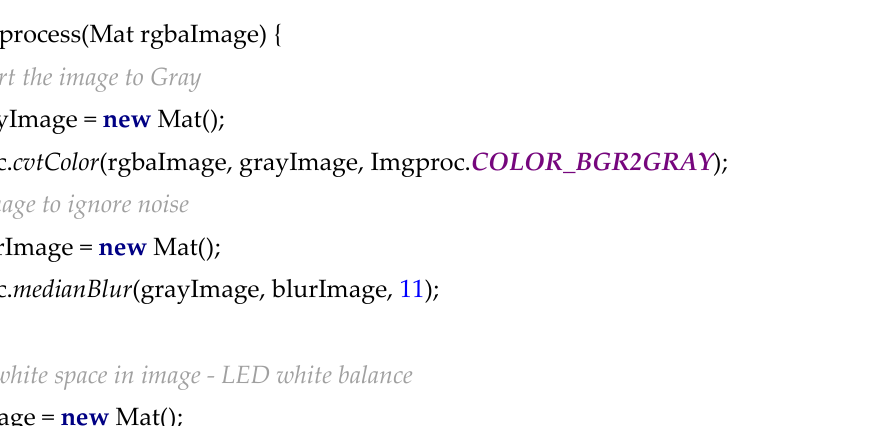
Figure 12. Example of the key transmission.